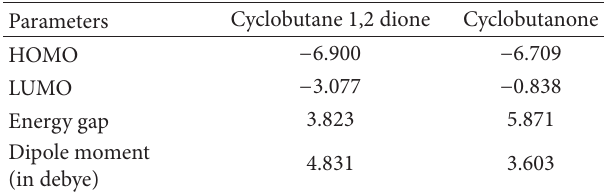
T 7: HOMO-LUMO gap (Frontier orbital energy gap) and Dipole Moment of 1,2-cyclobutanedione and cyclobutanone by (B3PW91)/6-31G (dp) methods.